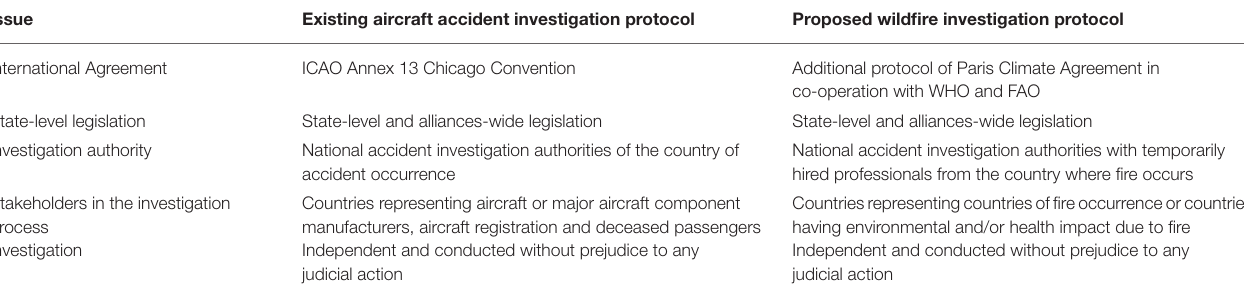
TABLE 1 | Comparison of administrative protocols between current international aircraft and proposed forest fire accident